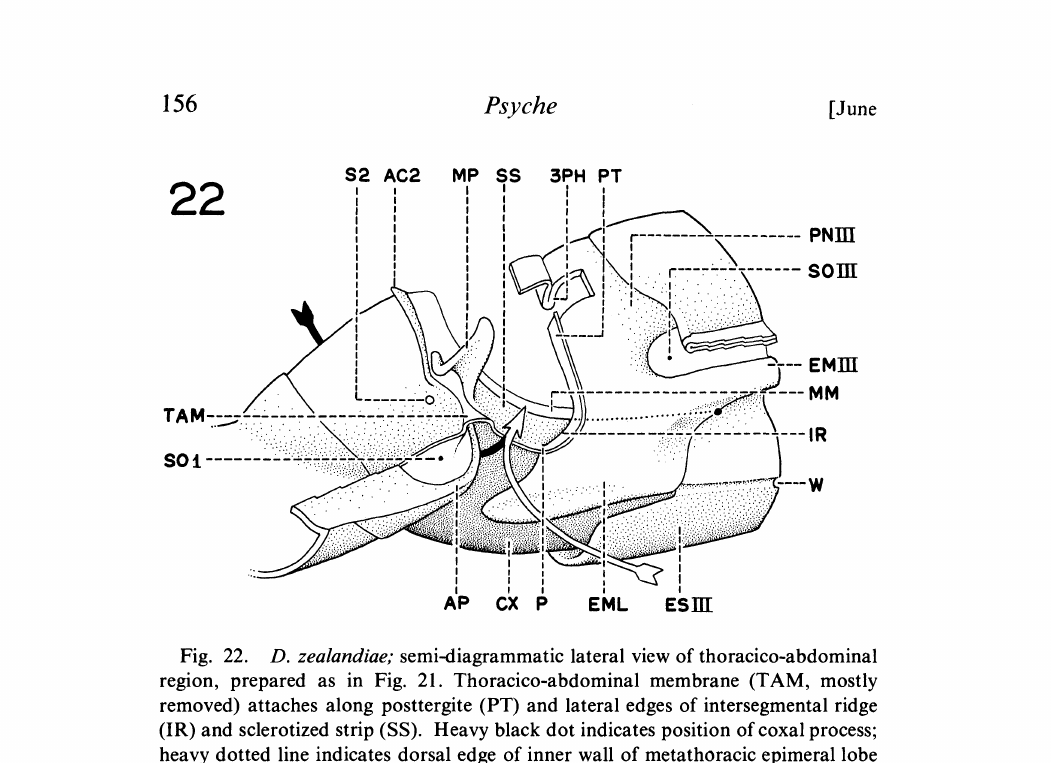
Fig. 22. D. zealandiae; semi-diagrammatic lateral view of thoracico-abdominal region, prepared as in Fig. 21. Thoracico-abdominal membrane (TAM, mostly removed) attaches along posttergite (PT) and lateral edges of intersegmental ridge (IR) and sclerotized strip (SS). Heavy black dot indicates position of coxal process; heavy dotted line indicates dorsal edge of inner wall of metathoracic epimeral lobe (EML). Head of arrows indicates position of first abdominal spiracle (removed) in thoracico-abdominal membrane; spiracle communicates with ventral air store (white arrow) and with air store surrounding metacoxa (black